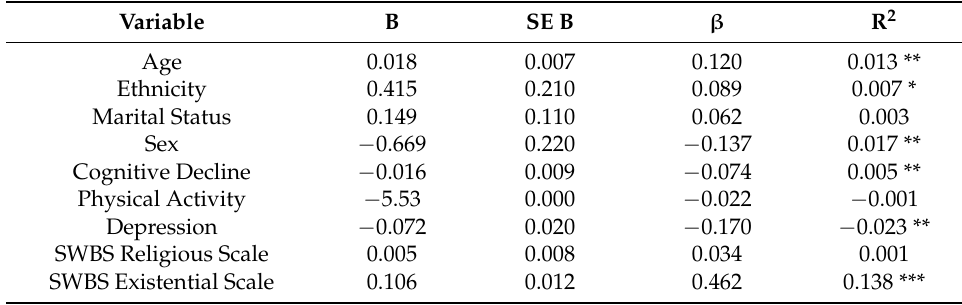
Table 4. Summary of Regression Analysis for Variables Predicting Pemberton Experienced Happiness Index (PHI